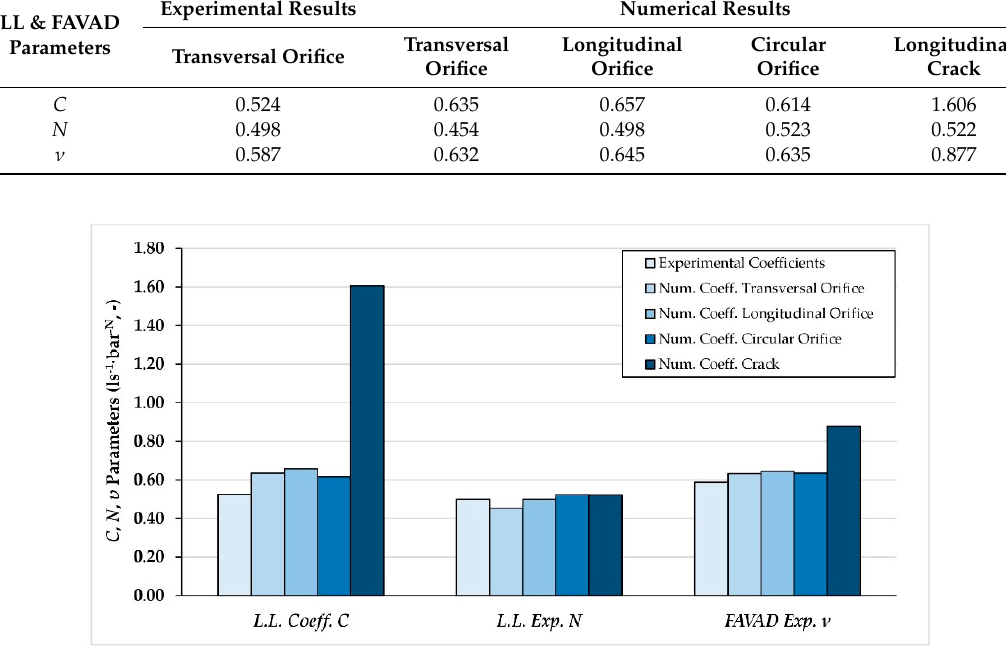
Figure 8. Comparison between experimental and numerical calibration of leakage law and FAVAD parameters. Table 8. Calibration of leakage law and FAVAD parameters with experimental and numerical analysis.